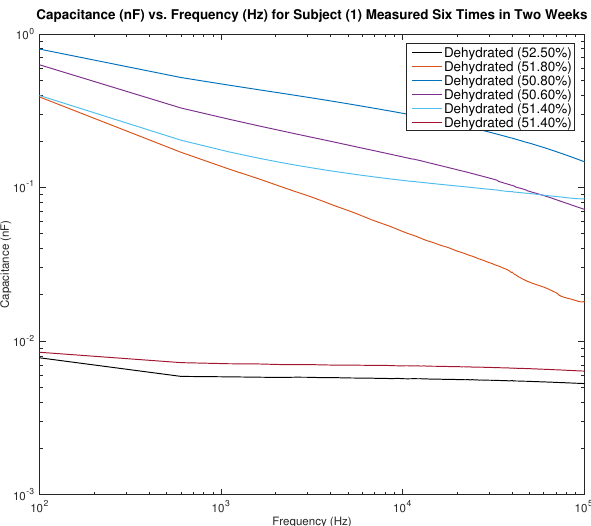
Figure 13. Testing results—capacitance (nF) vs. frequency (Hz) for subject 1 measured six times in two weeks on the left arm.